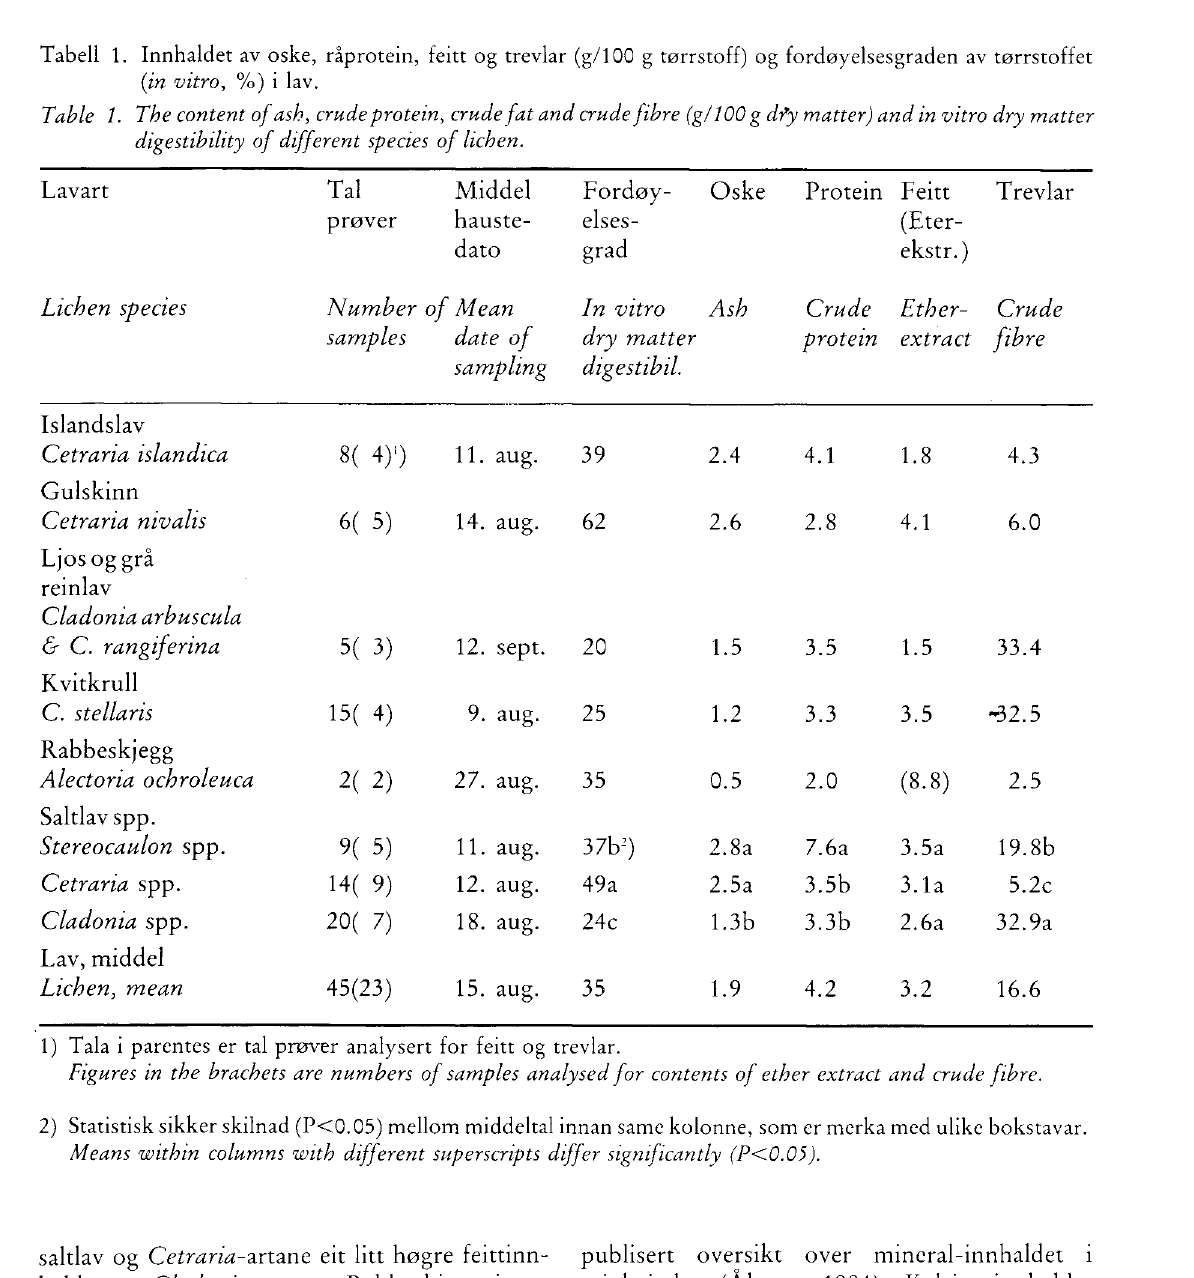
Tabell 1. Innhaldet av oske, råprotein, feitt og trevlar (g/100 g tørrstoff) og fordøyelsesgraden av tørrstoffet (in vitro, %) i lav. Table 1. The content of ash, crude protein, crude fat and crude fibre (g/100 g dfy matter) and in vitro dry matter digestibility of different species of lichen. Lavart Tal Middel Fordøy- Oske Protein Feitt Trevlar prøver hauste- elses- (Eter- dato grad ekstr.) Number of Mean In vitro Ash Crude Ether- Crude dry